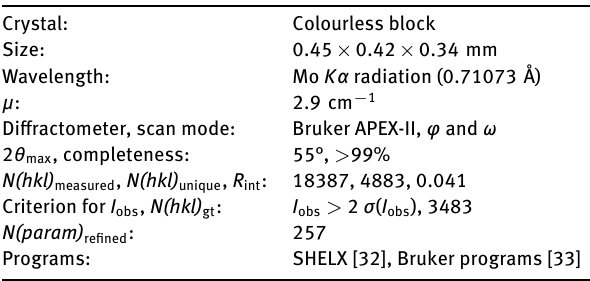
Table 1: Data collection and